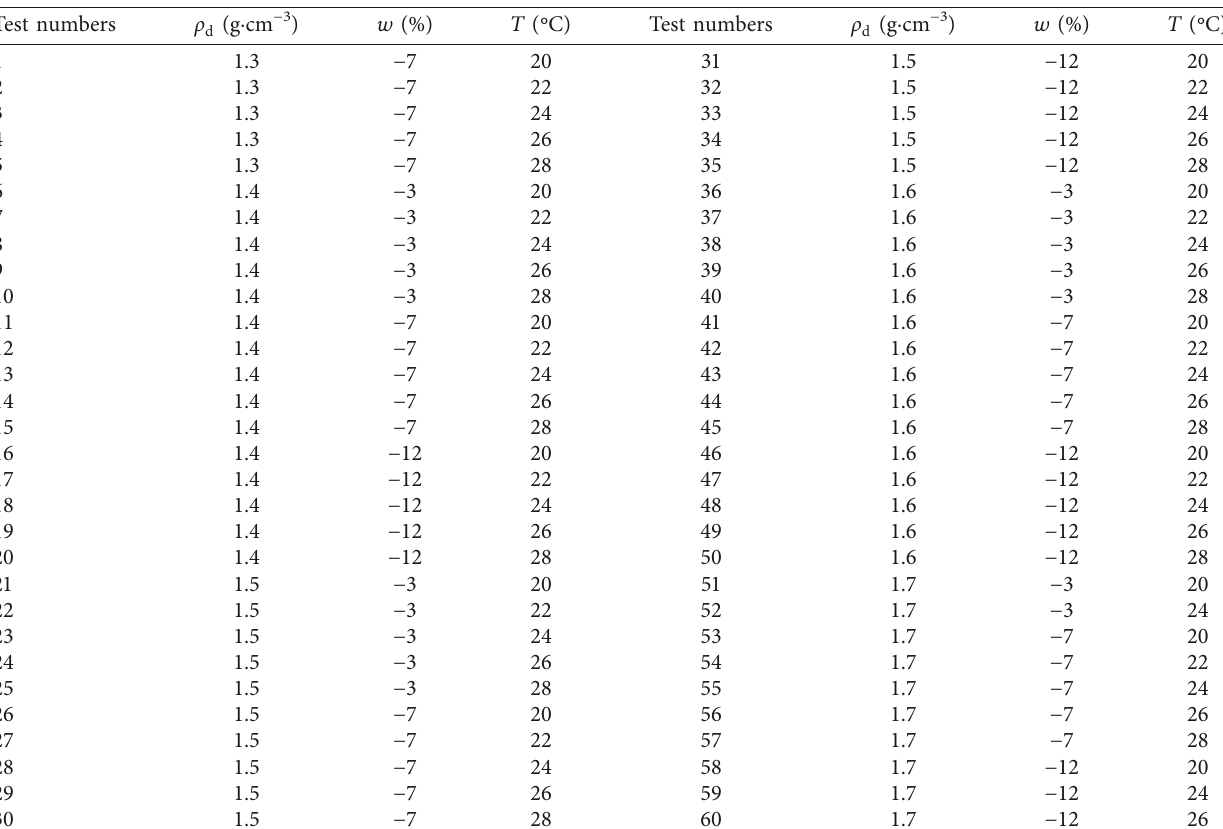
Figure 1: Testing Table 2: Parameter values for each group of soil samples tested.